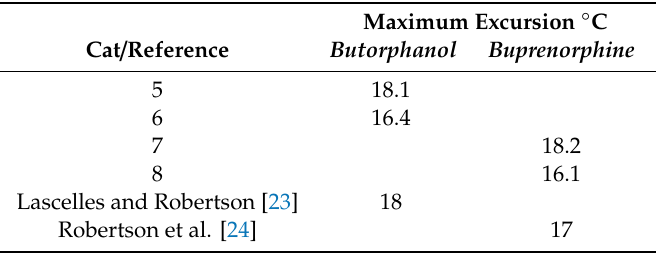
Table 2. Thermal thresholds (TTs) in group DEV1b cats. Peak excursions (skin–TT di ff erence) after treatment with intramuscular (IM) butorphanol 0.4 mg / kg or sub-lingual (SL) buprenorphine 20 µ g / kg. Published approximate mean peak delta T data after buprenorphine and butorphanol included for